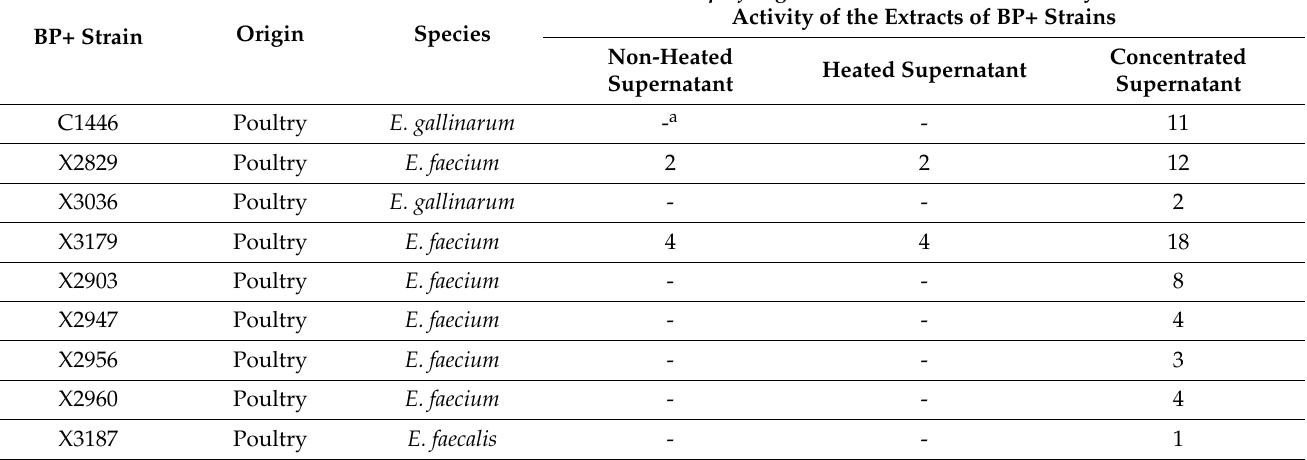
Figure 2. Inhibition halo of the E. faecium strain, X3179, against one of the 20 C. perfringens isolates. The bigger halo corresponds to the activity of nisin, used as a control. Table 2. The number of C. perfringens isolates to which the supernatants of 18 BP+ enterococci present antimicrobial activity in their supernatants.